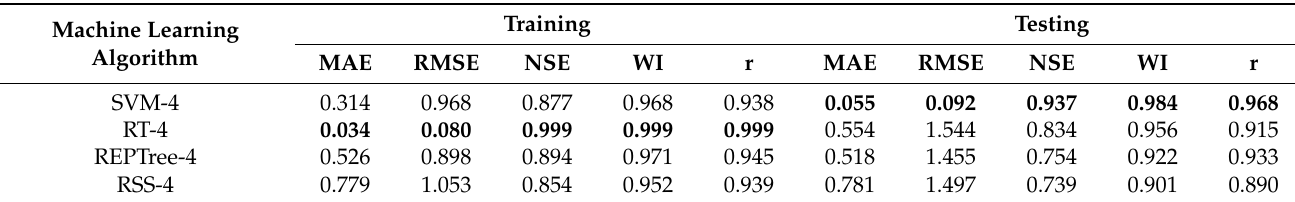
Table 7. RMSE, NSE, WI, and r for meta-heuristic algorithms-based models during the training and testing phase at the New Delhi station. Machine